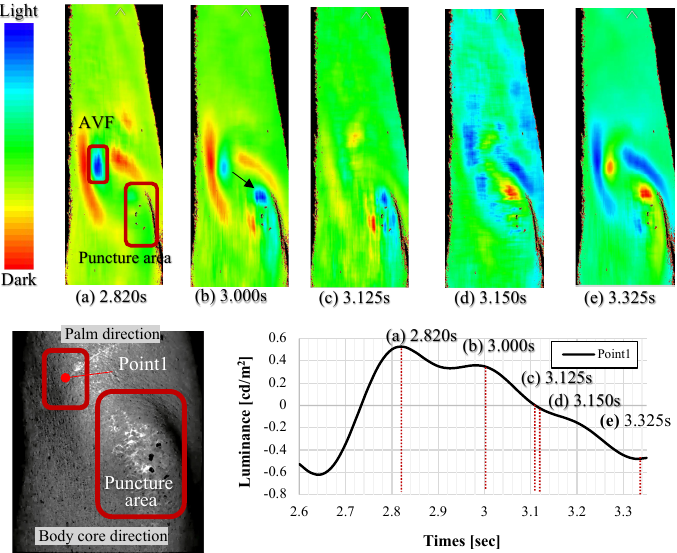
Figure 11. Continuous color -mapping image of AVF pulse wave for one cycle (2.600 to 3.360s, the band pass filter was applied). ( a ) Anastomotic tense phase (2.820s). ( b ) Transition from anastomosis to puncture site (3.000s). ( c ) Peak puncture site phase (3.125s). ( d ) Anastomotic relaxation phase (3.150s). ( e ) End of anastomotic relaxation phase